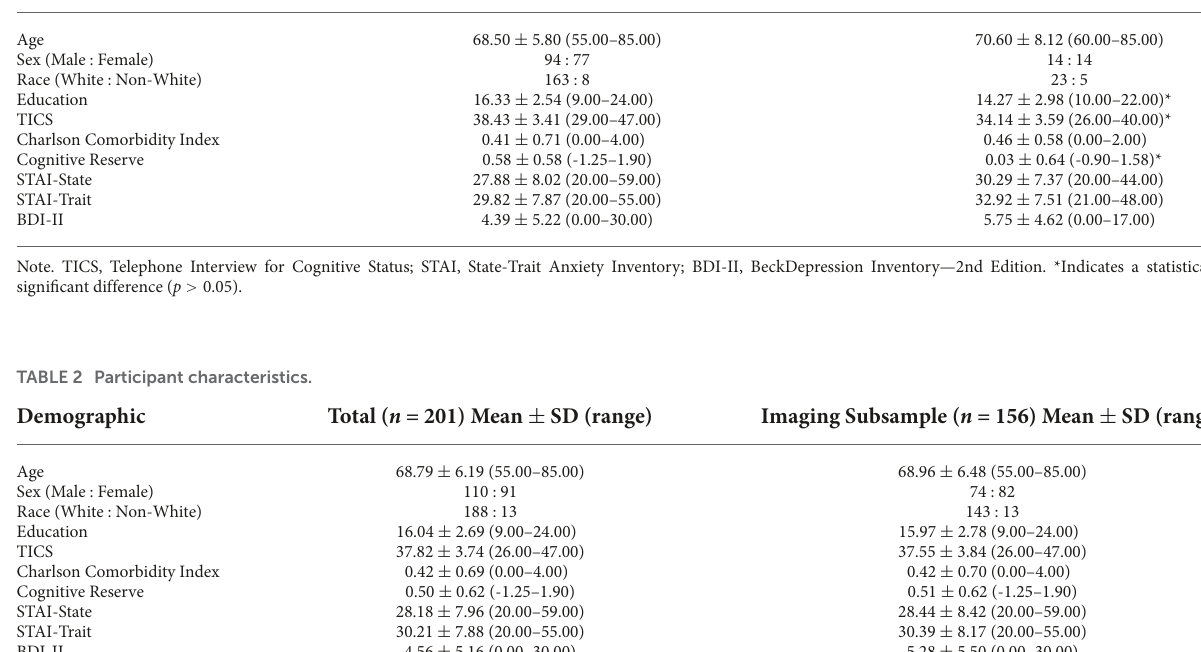
TABLE 1 Participant characteristics by MCI status.